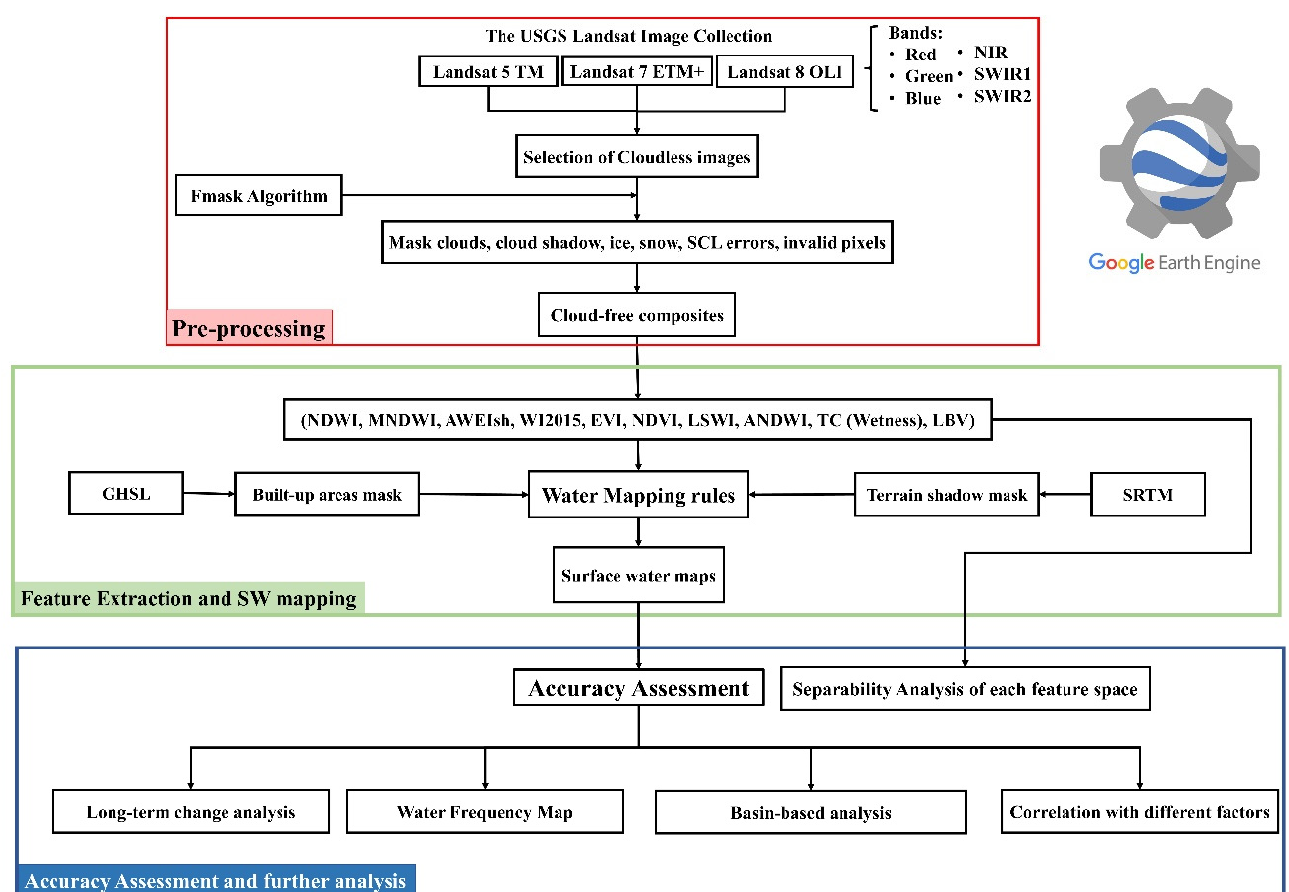
Figure 3. Proposed methodology framework.